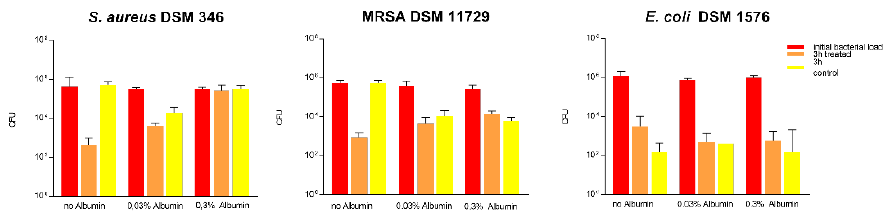
Figure 9. Quantification of viable bacteria using a dry assessment with protein soiling with 0.03% and 0.3% bovine albumin. The results of two independent experiments are shown. A volume of 10 µL of bacterial inoculum (without albumin, with 0.03% albumin, as well as 0.3% albumin) was dried under standard conditions on the 2.5% Cu(NO 3 ) 2 -containing sol–gel surface, as well as a sol–gel surface without additive (control). The initial number of bacteria was quantified immediately after inoculation and after 3 h of incubation. Mean numbers of bacteria per surface (CFU) are displayed on a logarithmic scale with error bars indicating the standard deviation of the respective means. The threshold for achieving a mean reduction of three log from the initial bacterial inoculum determines the efficacy of the presumed antibacterial surfaces.